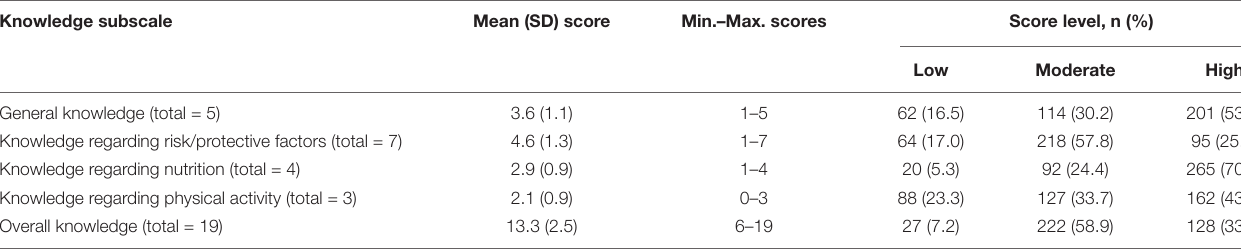
TABLE 2 | Knowledge scores among the